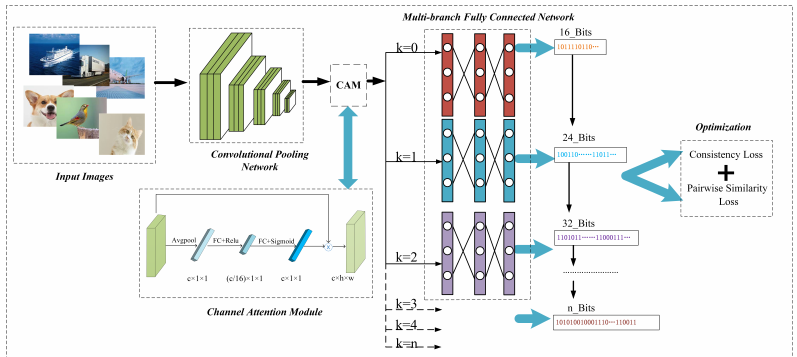
Figure 1. The overview architecture of